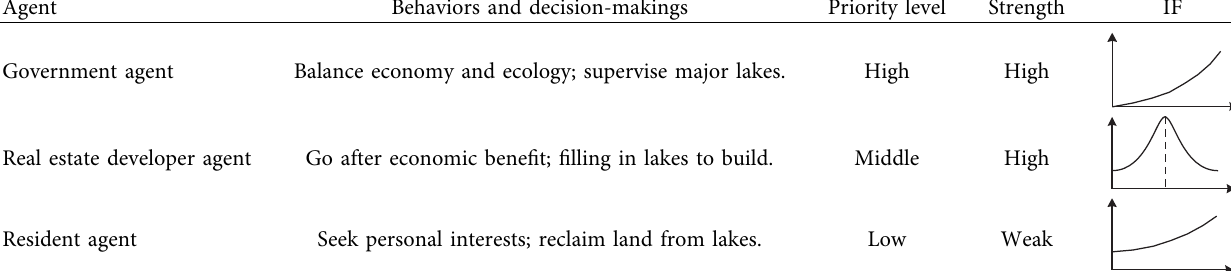
Table 5: Relationships between the government agent, the developer agent, and the resident agent. Agent